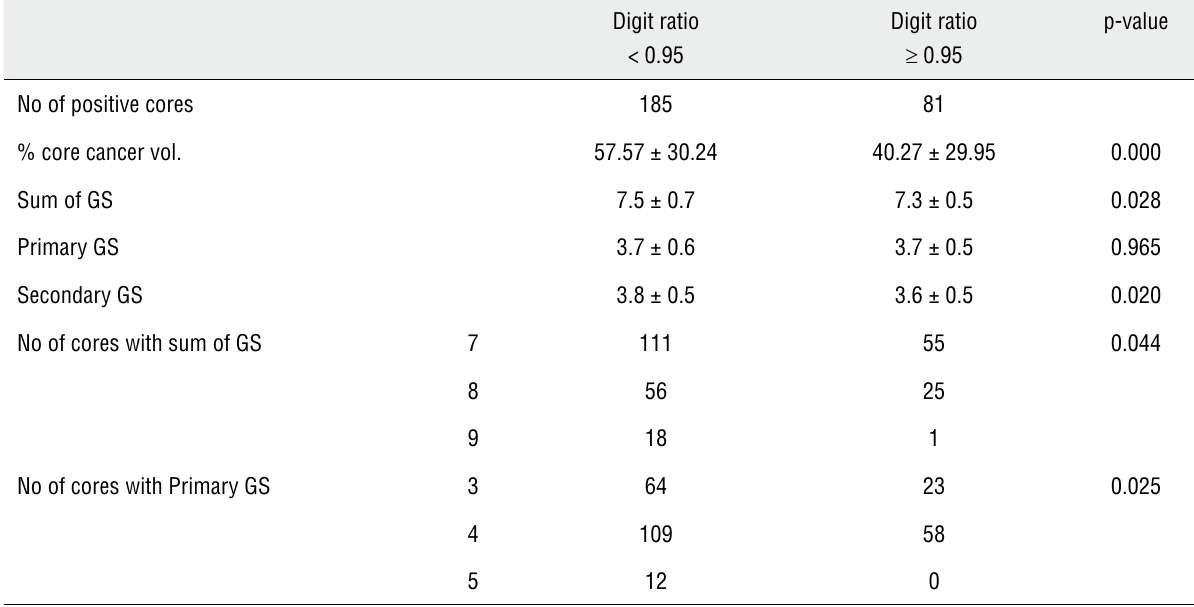
Table 6 - Comparison of the positive cores with GS ≥ 7 between the two studied